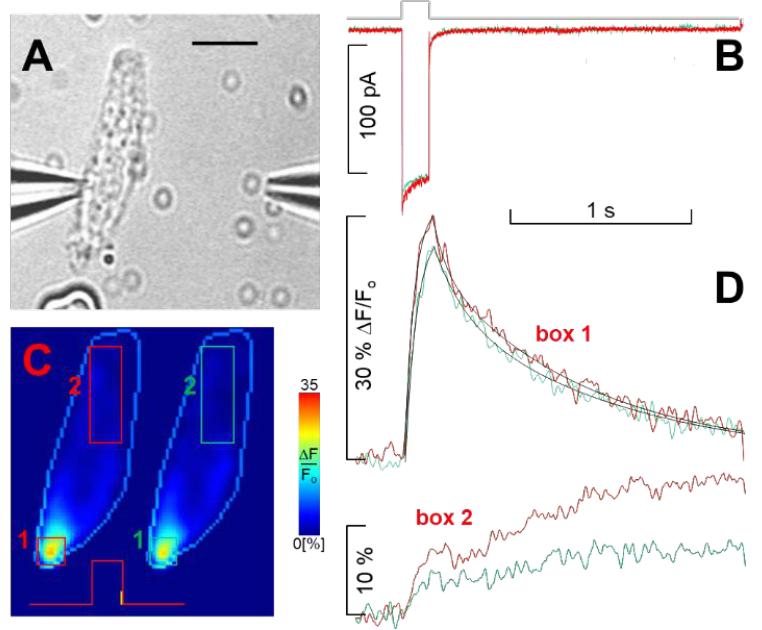
Figure 1. Ca 2+ channel selectivity in the presence of millimolar extracellular Ca 2+ and concurrent Ca 2+ dynamics. ( A ) Bright-field video micrograph of a patched cell (scale bar, 10 µ m), showing the location of the puff pipette used for drug application; choline solution ejection started 1 s prior to the onset of the recording and was maintained throughout; ( B ) whole-cell current in the control (red trace) during choline perfusion (green trace) in response to a 160 ms depolarisation to − 30 mV from V h , whose timing is indicated by the thick grey trace, which applies to panel ( D ) as well. ( C ) Two fluorescence ratio ( ∆ F / F o ) pseudo-colour images of the cell in ( A ), encoded according to the colour scale bar on the right (see Section 4 Methods), acquired just at the offset of the voltage pulse (i.e., when intracellular Ca 2+ is maximal, indicated with the vertical yellow mark superimposed on the voltage command) in the control (left) and during choline application (right); the light blue contour line delineates the cell boundary, enlarged 1.2-fold compared to ( A ) for clarity. ( D ) Time course and spatial distribution of percent Ca 2+ fluorescence changes computed by averaging pixel signals within the 4 boxes shown ( C ) in the control (red numbers and red traces) and during choline perfusion (green). The black lines in the upper panel are non-linear fits to the rising phase (single exponential, time constant 52 ms for both control and choline perfusion) and to the falling phase (double exponential, time constants τ 1 = 80 ms and τ 2 = 850 ms in the control, τ 1 = 160 ms and τ 2 = 1010 ms in choline) of the fluorescence signals computed in box 1. The lower panel shows the dynamics of Ca 2+ diffusion from the entry site at the basal pole toward the cell apex (box 2) in the control (red number and trace) and during choline perfusion (green). The same time base applies to both electrophysiological and fluorescence